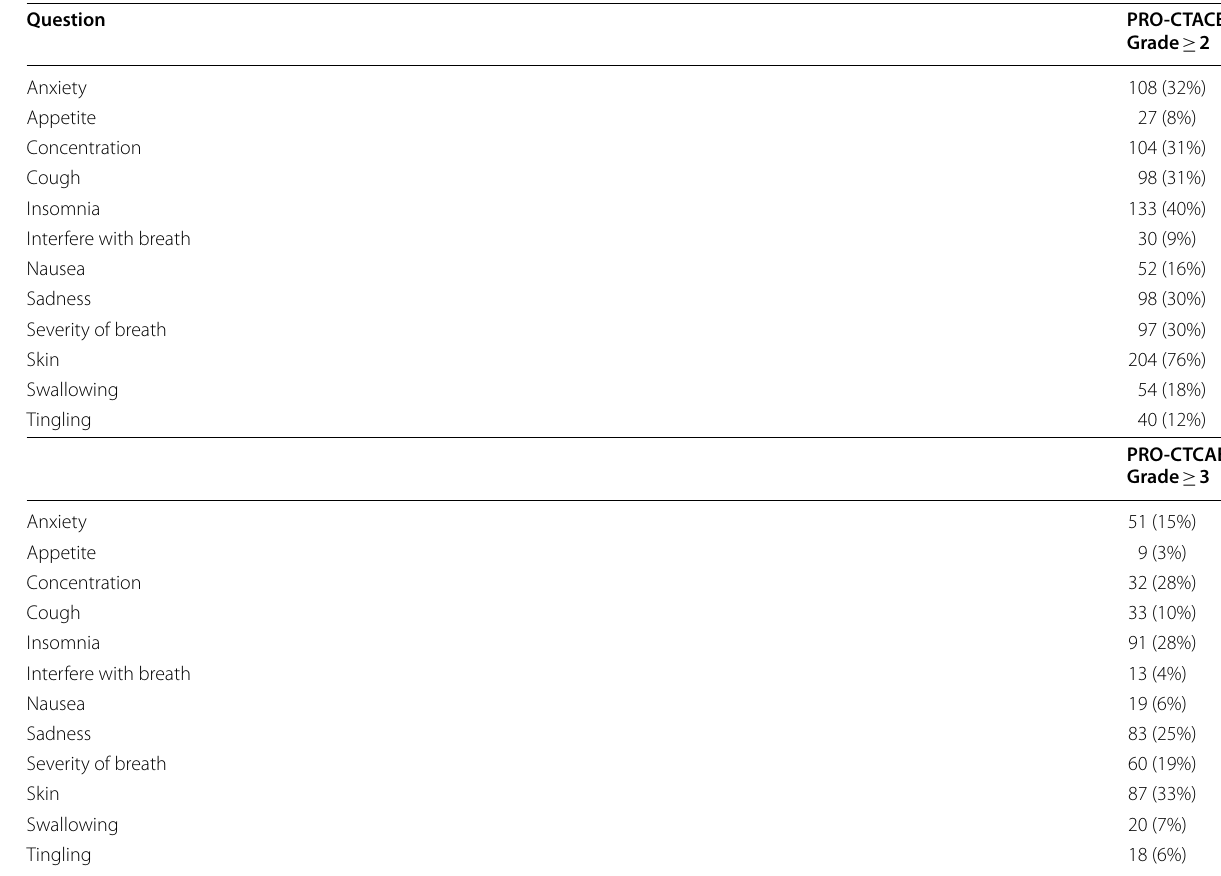
Table 3 PRO‑CTCAE Grade